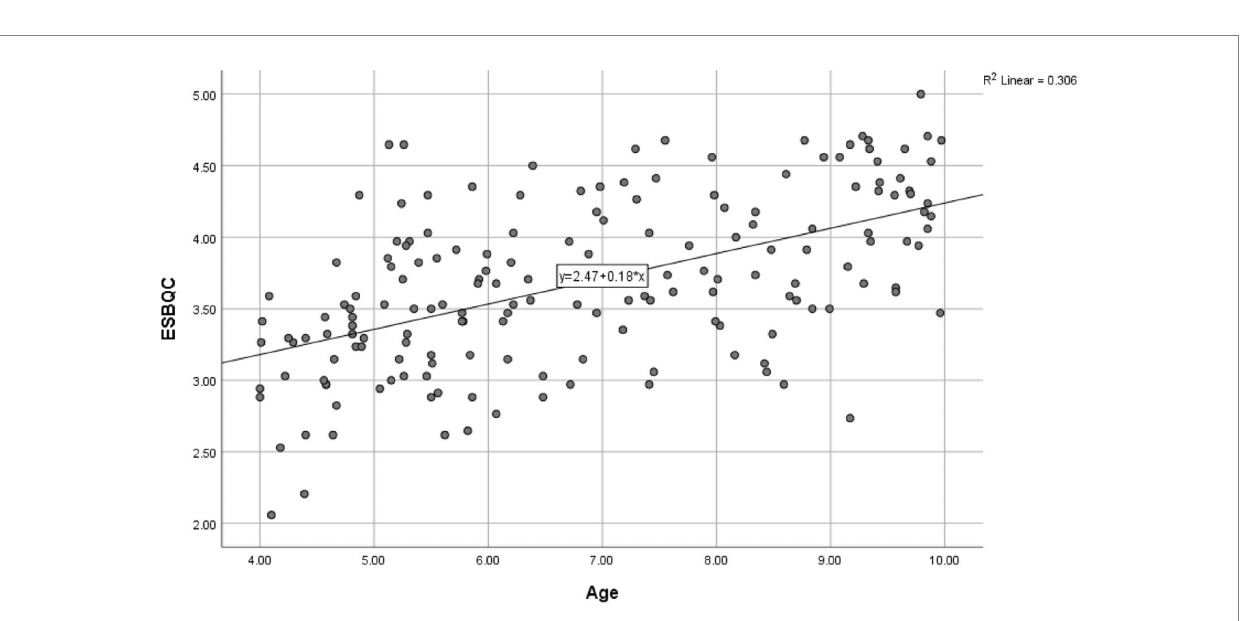
FIGURE 1 ESBQC as a function of age.